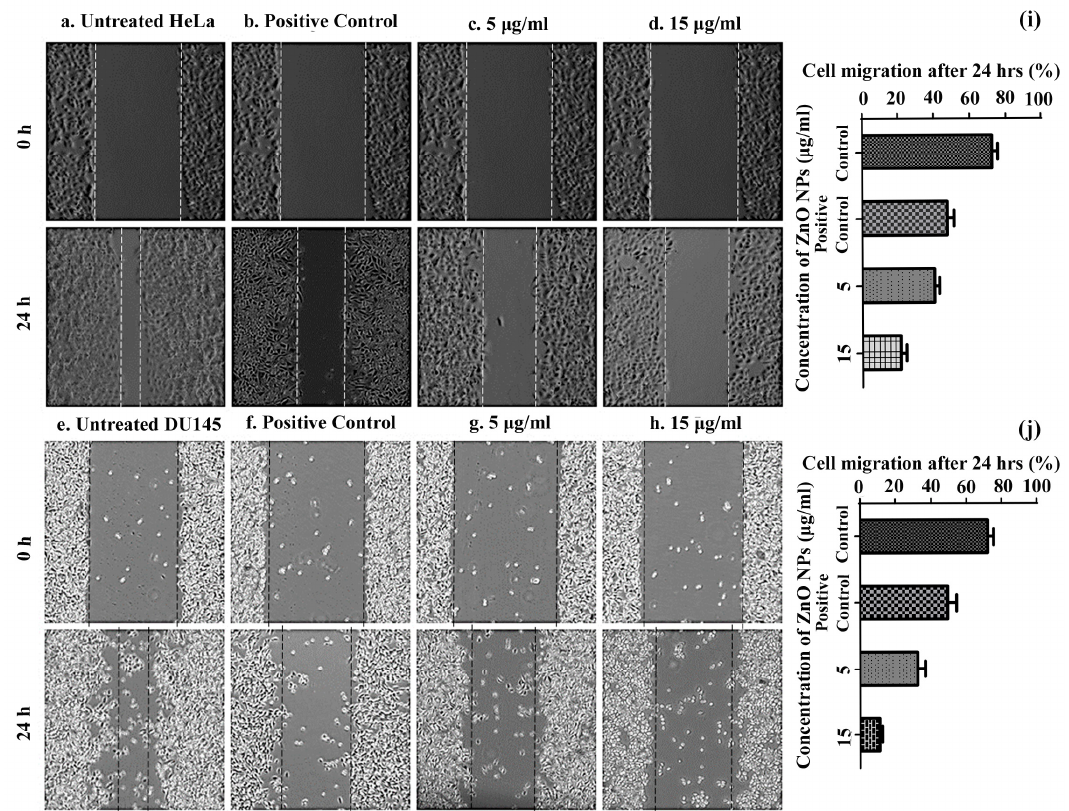
Figure 8. Analysis of HeLa and DU145 cell migration by in vitro scratch assay observed at 4× magnification under fluorescent inverted microscope and quantified using ImageJ software. ( a ) Untreated HeLa control at 0 and 24 h, ( e ) Untreated DU145 control at 0 and 24 h, aqeous leaf extract treated negative control at 0 and 24 h in ( b ) HeLa ( f ) DU145 cell lines. Low concentration of ZnO NPs treatment (5 µg/mL) at 0 and 24 h in ( c ) HeLa and ( g ) DU145 cell lines. High concentration of ZnO NPs treatment (15 µg/mL) at 0 and 24 h in ( d ) HeLa and ( h ) DU145 cell lines. ( i ) Relative inhibition of cell migration due to all treatments and controls in both cell lines after 24 h.